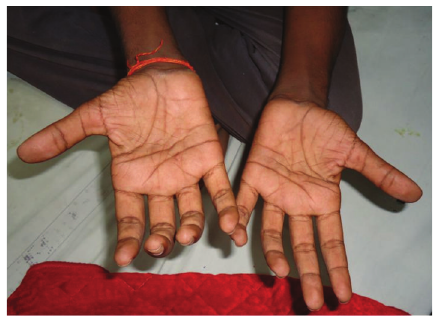
Figure 2: Symmetrical bilateral atrophy of hand muscles.